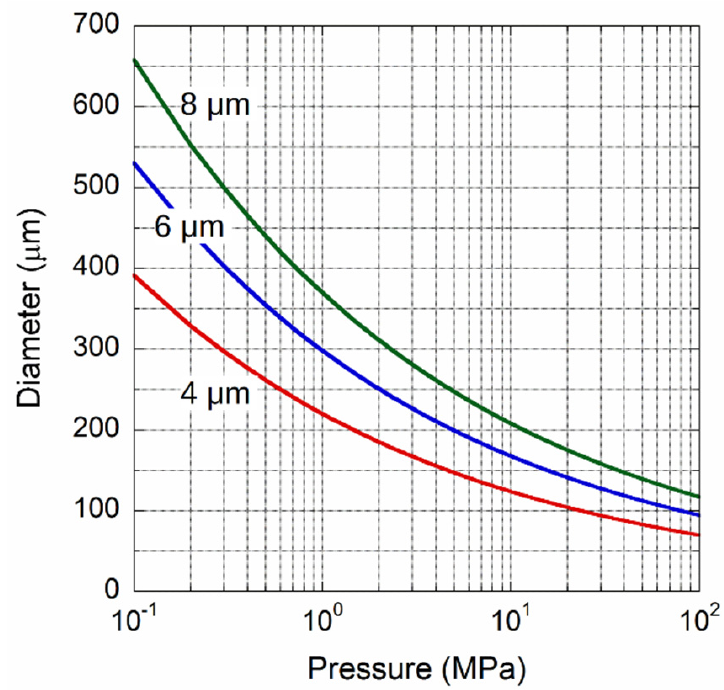
Figure 4. Calculated membrane diameter as a function of the pressure limit giving a displacement 387.5 nm ( λ /4) for film thicknesses of 4, 6, and 8 µ of 387.5 nm ( λ /4) for film thicknesses of 4, 6, and 8 μ m. The diamond membranes were prepared using procedures described elsewhere [41].